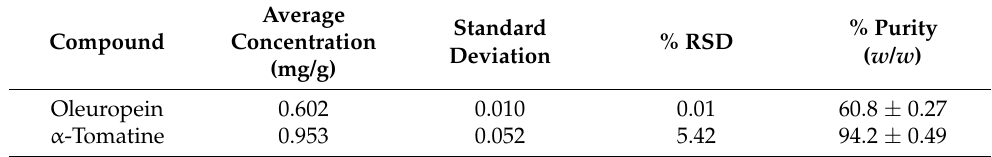
Table 1. The concentration of main components in the tomato and olive leaf extracts ( n =